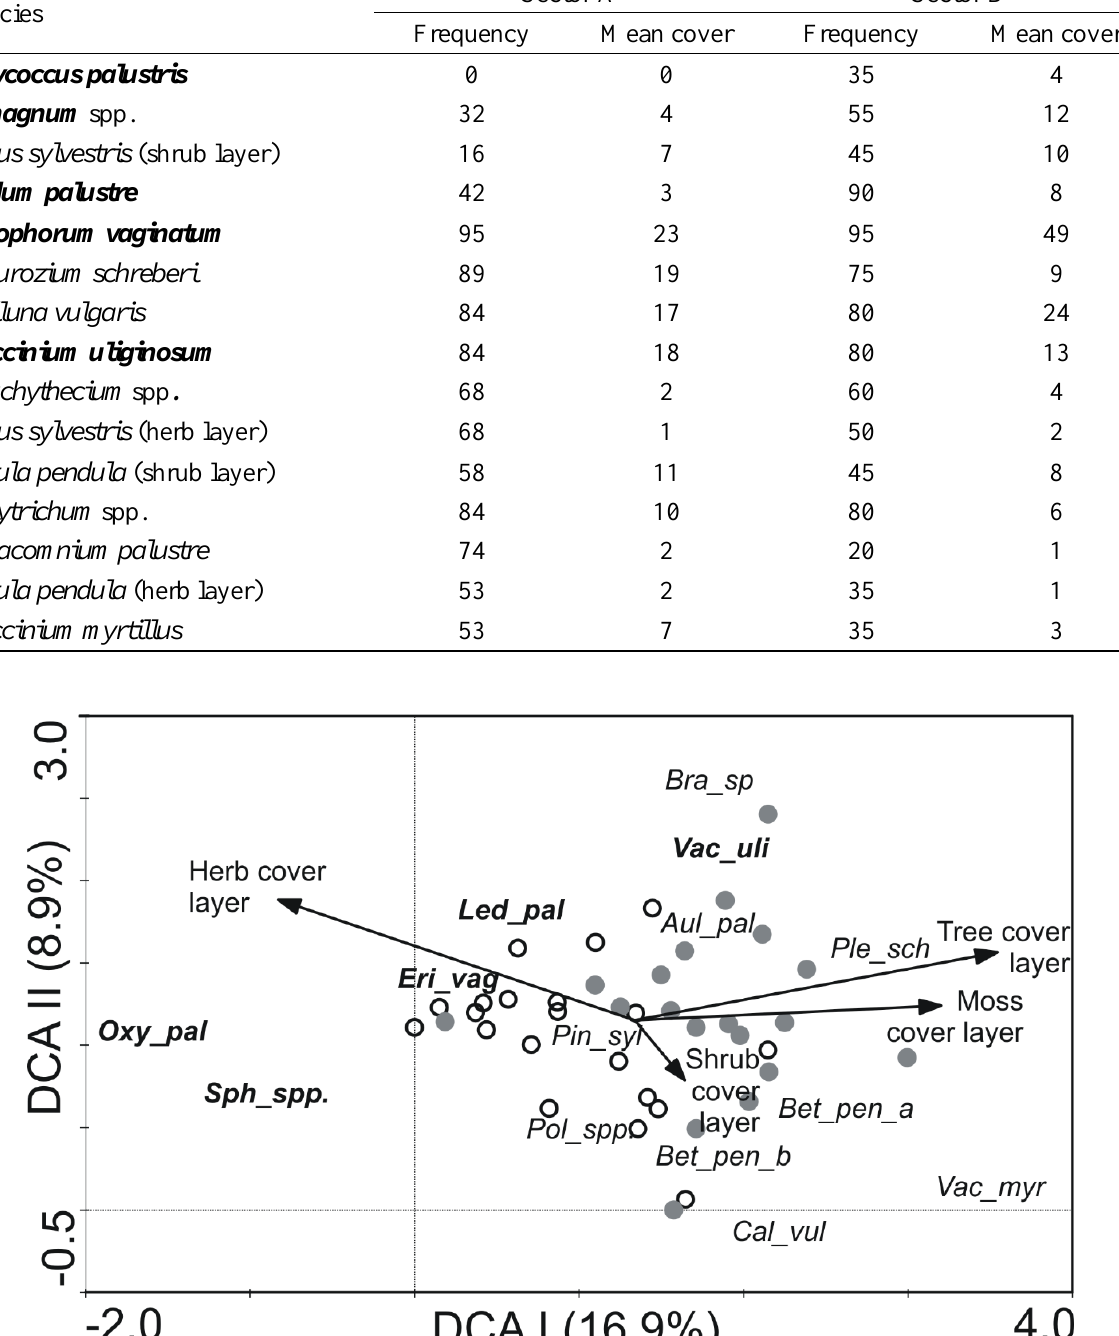
Table 3. Frequency of occurrence (%) of plant species and mean plant cover (%) calculated only for plots where the species was present. Only species with frequency > 50 % and raised bog species ( bold ) are presented. Sector A Species